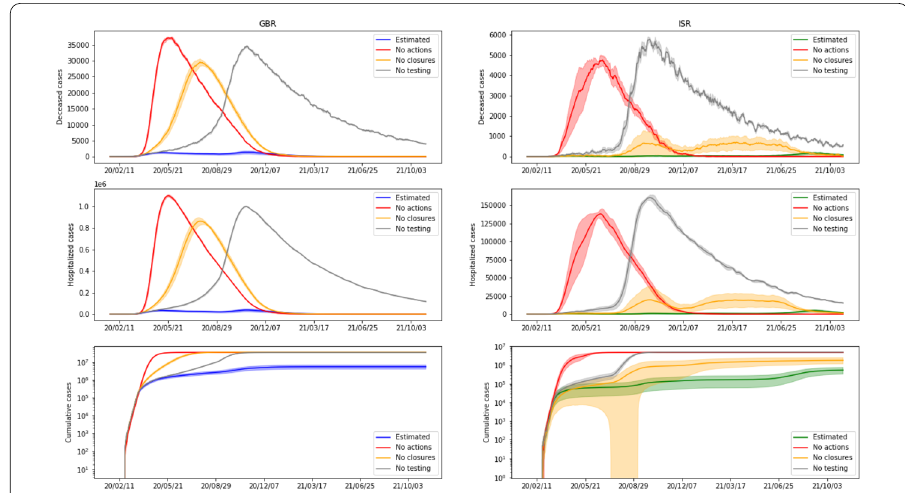
Figure 8 Scenarios(1,2,3) . Comparison between three different relaxations on containment measures and the true ones. Scenario1 , labeled ‘No actions’, considers the evolution of the pandemic without any government intervention. Scenario2 , labeled ‘No closures’, takes into account testing and contact tracing, but no further restrictions (e.g. lockdown or workplace closing). Scenario3 , labeled ‘No testing or tracing’, is a complement setting of Scenario2 , with restrictions on movement but no contact tracing or testing in place. Vaccination campaign proceeds as in the data for the latter two settings. We present cumulative cases, hospitalized and deceased for both GBR (on the left) and ISR (on the